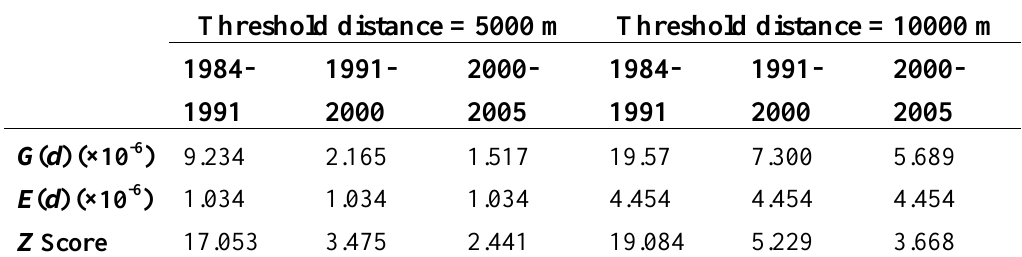
Table 2. Global G of SII whose spatial weights are constructed based on contiguities from the nearest